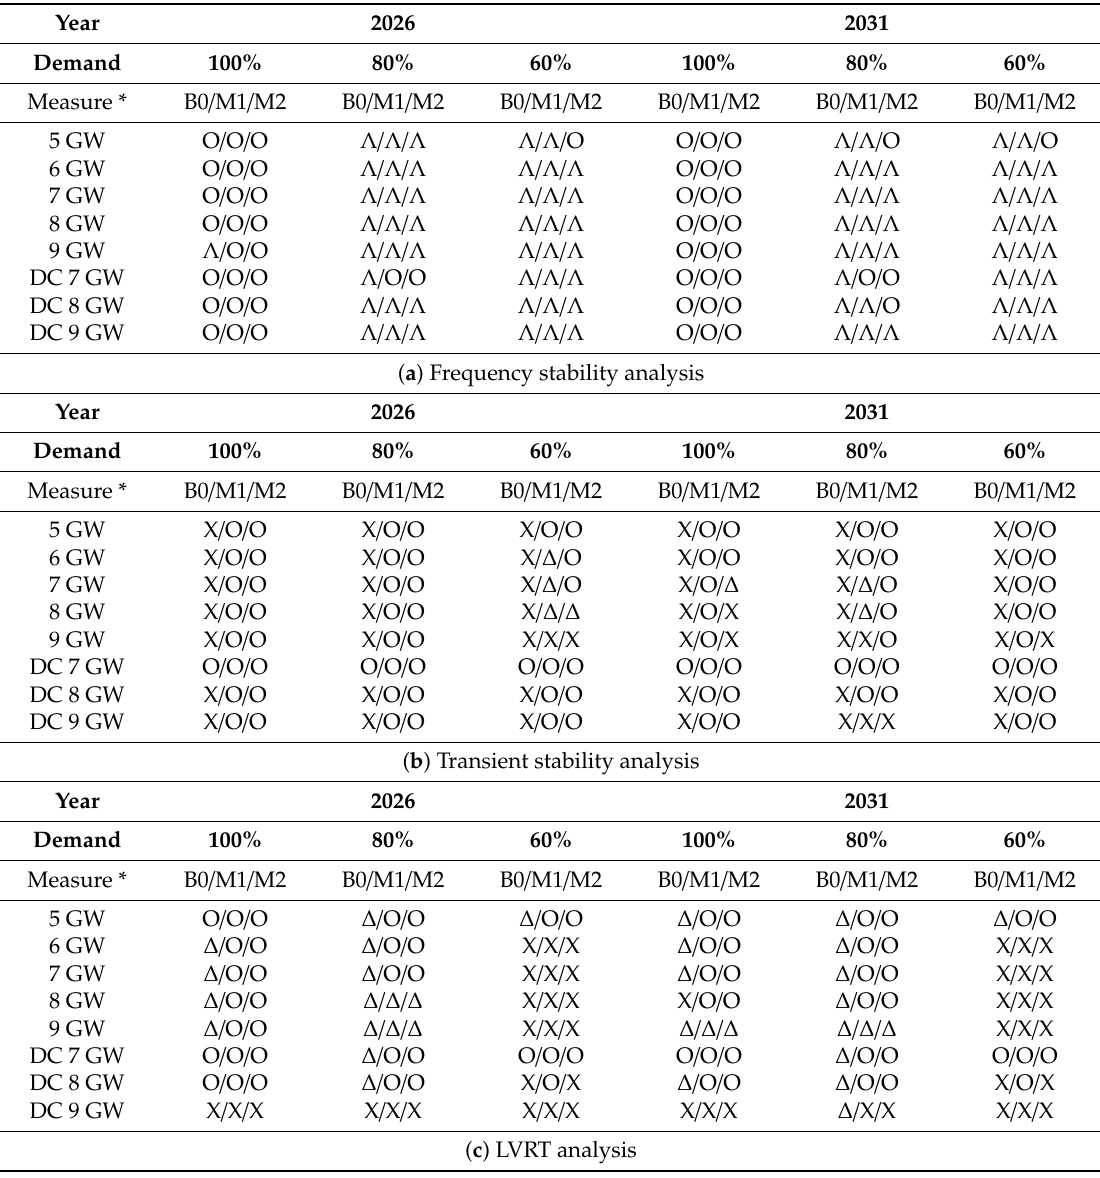
Table 20. Summary of dynamic analysis based on frequency stability, transient stability and LVRT after